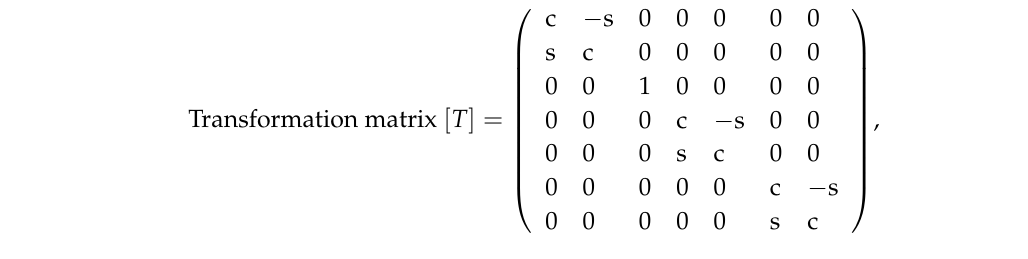
Table 1. Temperature ‐ dependent material properties of (10, 10) SWCNT (L = 9.26 nm, R = 0.68 nm, h